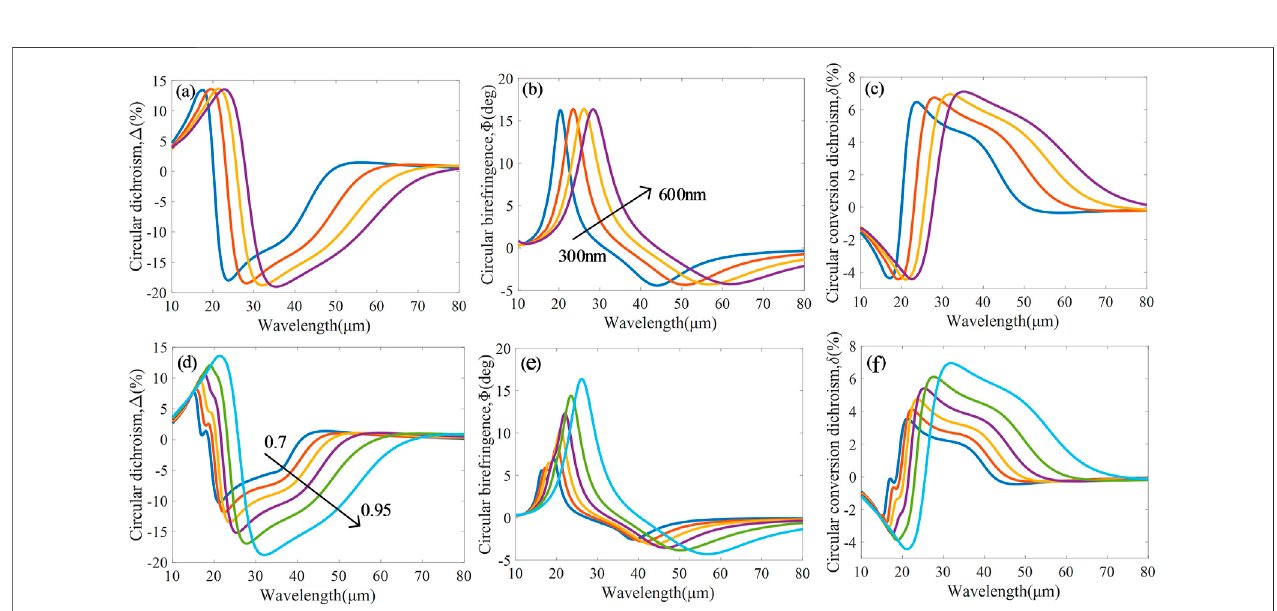
FIGURE 1 |(A) Illustration ofthe square monolayer BP metamaterial. The metamaterial consists ofan array of square BP nanostructures. The red and blue arrows indicateright-handed(RCP)andleft-handed(LCP)circularlypolarizedwaves,respectively. α denotestheazimuthalanglebetweentheincidentplaneandthe x -direction. β denotes the elevation angle. (B) Transmittance, (C) circular dichroism, (D) circular birefringence, and (E) circular conversion dichroism of the square BP metamaterial. Here, n = 6 × 10 13 cm − 2 , p = 500 nm, k = 0.95, β = 75 ° , and α = 45 ° . The EM fi eld distribution of the BP metamaterial for the (F) LCP and (G) RCP incidence.